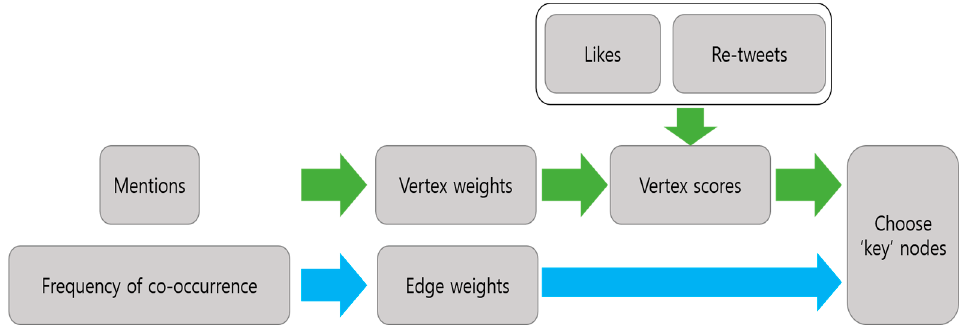
Figure 3. Overall procedure of selecting the key nodes.